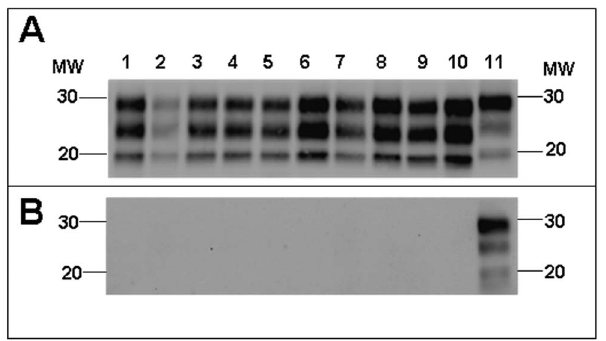
Figure 5. PrP res in PoPrP-Tg001 mice. Electrophoretic profiles and antibody labelling of PrP res as detected by mAbs Sha31 (A) and 12B2 (B) in brain extracts from PoPrP-Tg001mice inoculated with the different BSE-derived prions: cattle-BSE (lane 1), BoTg-BSE (lane2), sheep-BSE (lane 3), OvTg-BSE (lane 4), porcine-BSE (lane 5), PoTg-BSE (lane 6), mouse-BSE (lane 7), MoTga20-BSE (lane 8), human-vCJD (lane 9), HuTg- BSE (lane 10). Atypical cattle-BSE H isolate (lane 11) was included as positive control for 12B2 antibody labelling. Panels A and B were loaded with the same quantities of PrP res extracted from each sample. MW, molecular weight in kilodaltons.